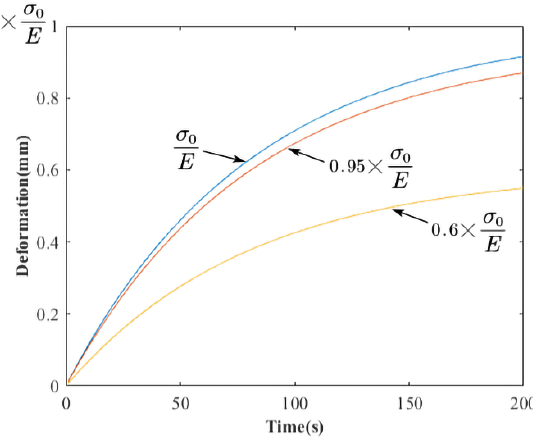
Figure 9. The creep curves described by Kelvin model.